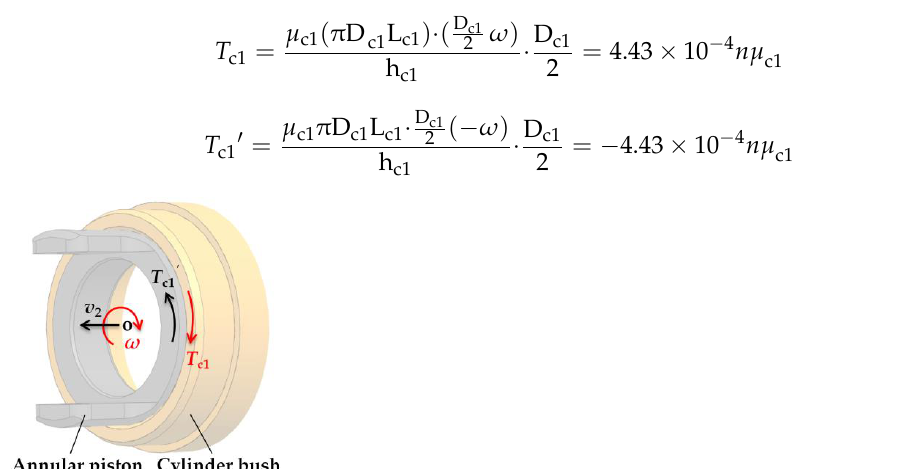
Figure 8. The torque of shearing flow by the annular piston. The power generated by the viscous resistance torque on the cylinder bush P c1 and